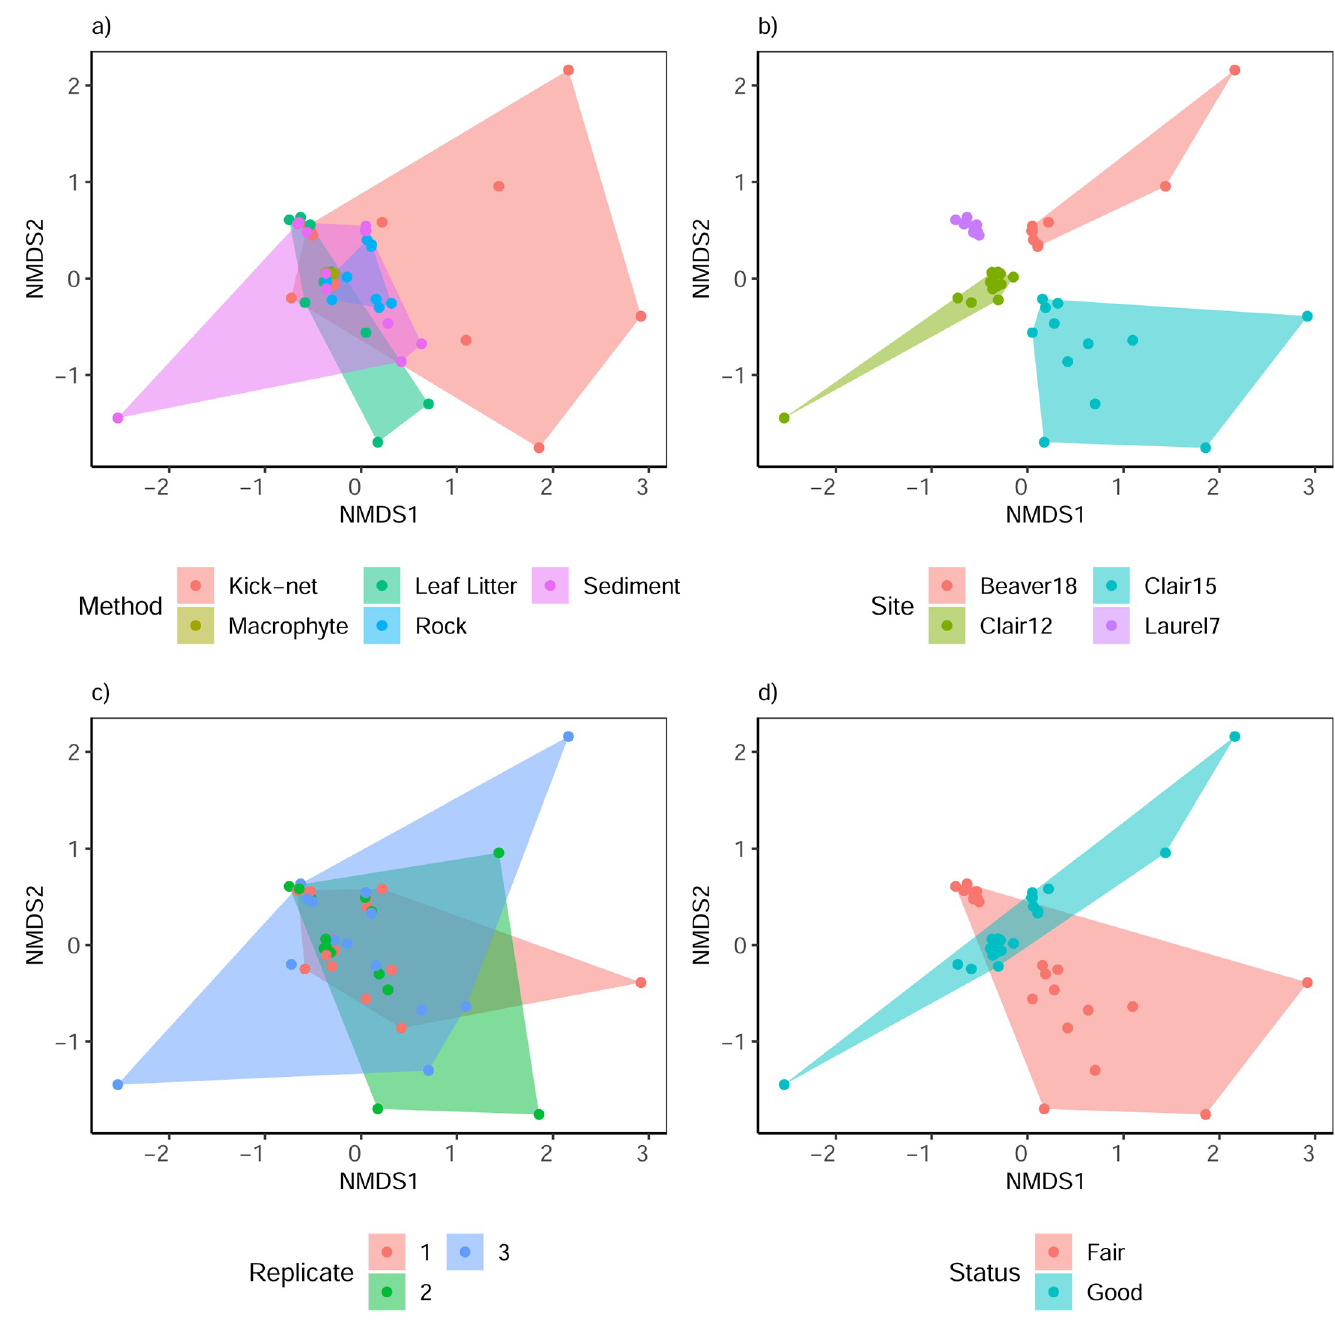
Fig 5. Non-metric multi-dimensional scaling plots show clustering mainly due to site and status. Specifically, a) binary Bray Curtis (Sorensen) dissimilarities overlapping across different sampling approaches, b) clustering by site, c) overlap between replicates, and d) clustering based on habitat quality status (stress = 0.109, R 2 = 0.98). Based on rarefied